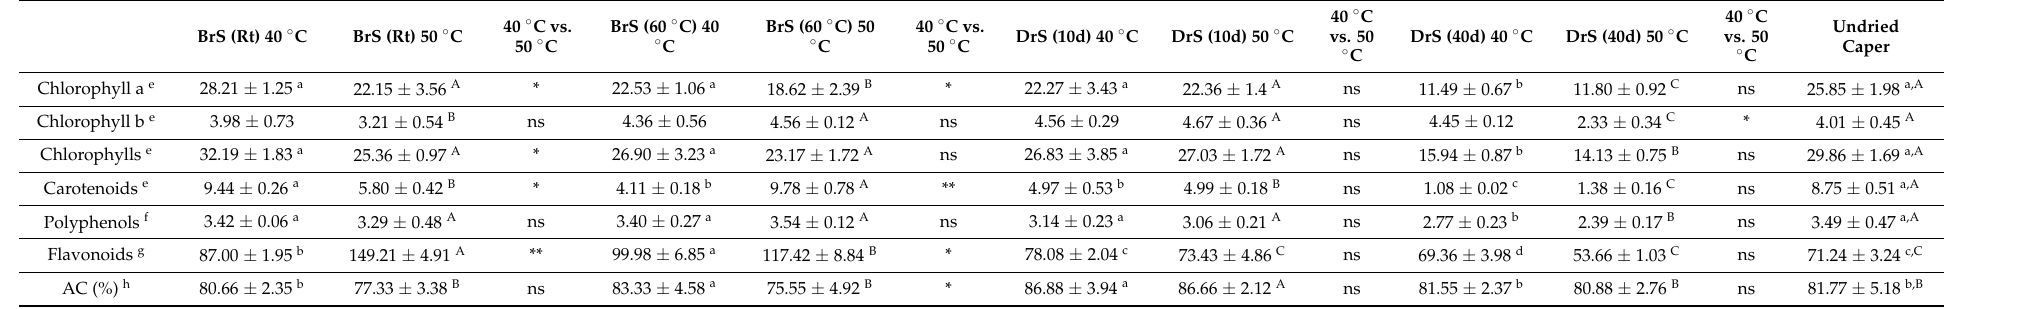
ANOVA: ** represents significant differences at p < 0.01, * represents significant differences at p < 0.05, and ns = not statistically significant ( p > 0.5) between samples obtained by the same trial dried at 40 and 50 ◦ C; a–c different superscript lower case letters in the same row represent significant differences at p < 0.05 determined by Duncan’s multiple range test among samples of different trials dried at 40 ◦ C and undried capers; A–C different superscript capital letters in the same row represent significant differences at p < 0.05 determined by Duncan’s multiple range test among samples of different trials dried at 50 ◦ C and undried capers; e mg/100g dry matter; f mgEQ gallic acid/g dry matter; g mgEQ quercetin/g dry matter; h total antioxidant capacity expressed as % of DPPH